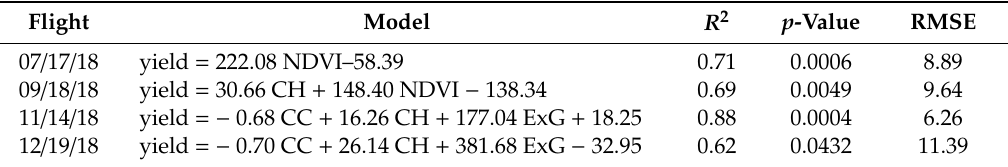
Table 4. Energy cane yield models with the coe ffi cient of determination, p -value, and RMSE for the flight campaigns.